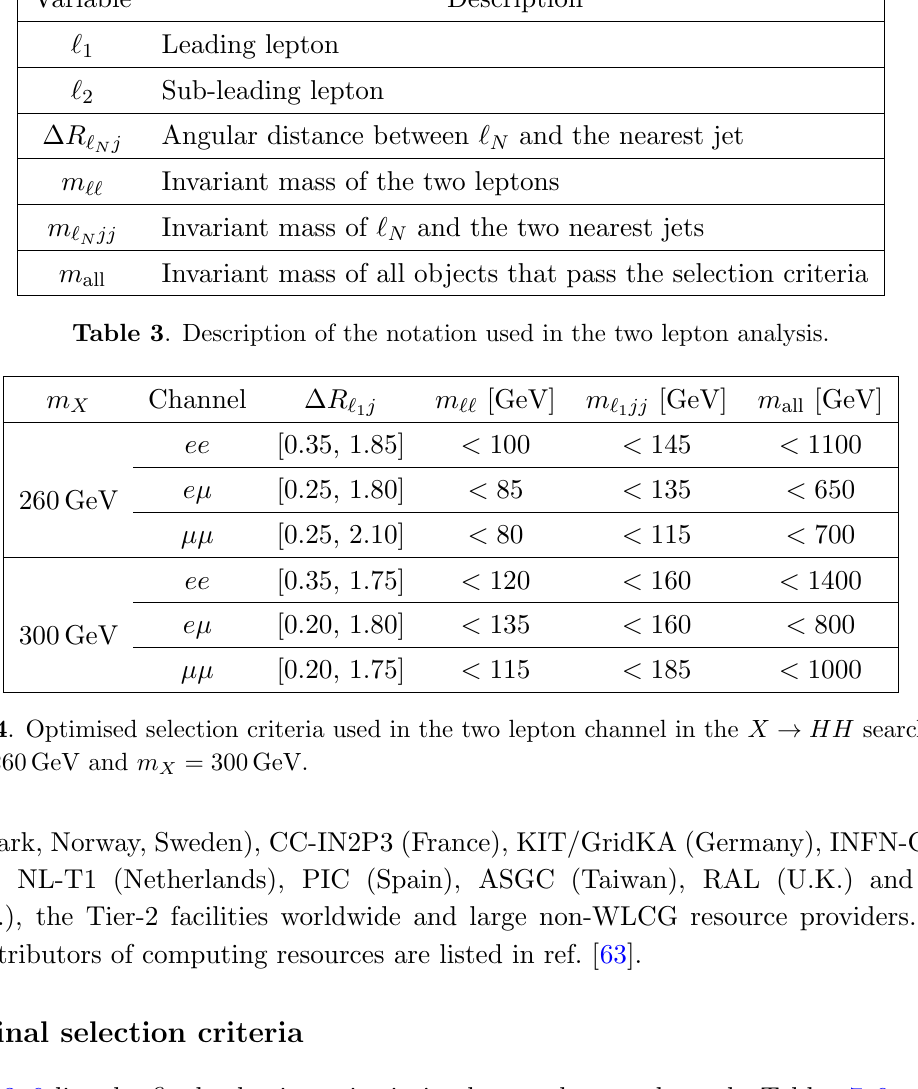
Tables 3{6 list the (cid:12)nal selection criteria in the two lepton channel. Tables 7{9 present the (cid:12)nal selection criteria in the three lepton channel. Table 10 de(cid:12)nes the variables